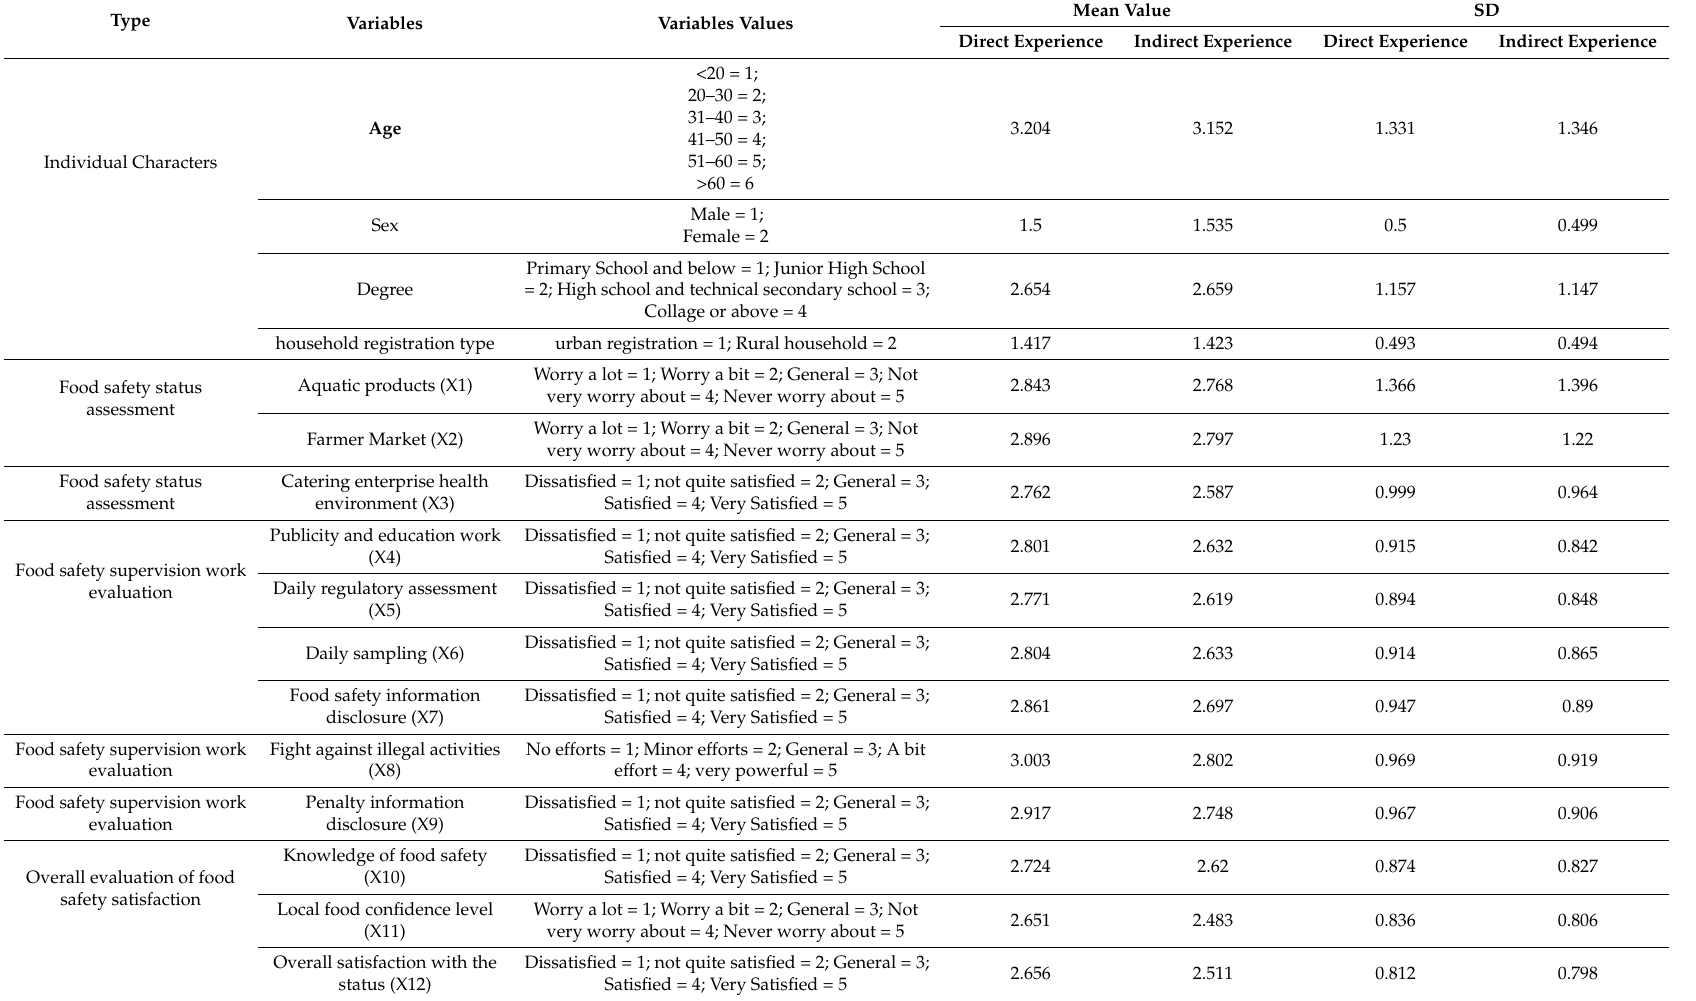
Table 3. Variables’ meanings, values, and corresponding